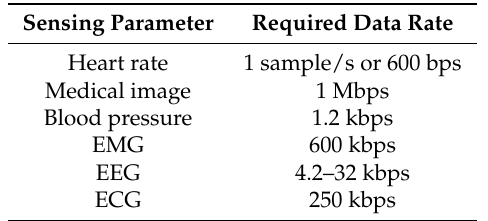
Table 3. IMD data traffic.